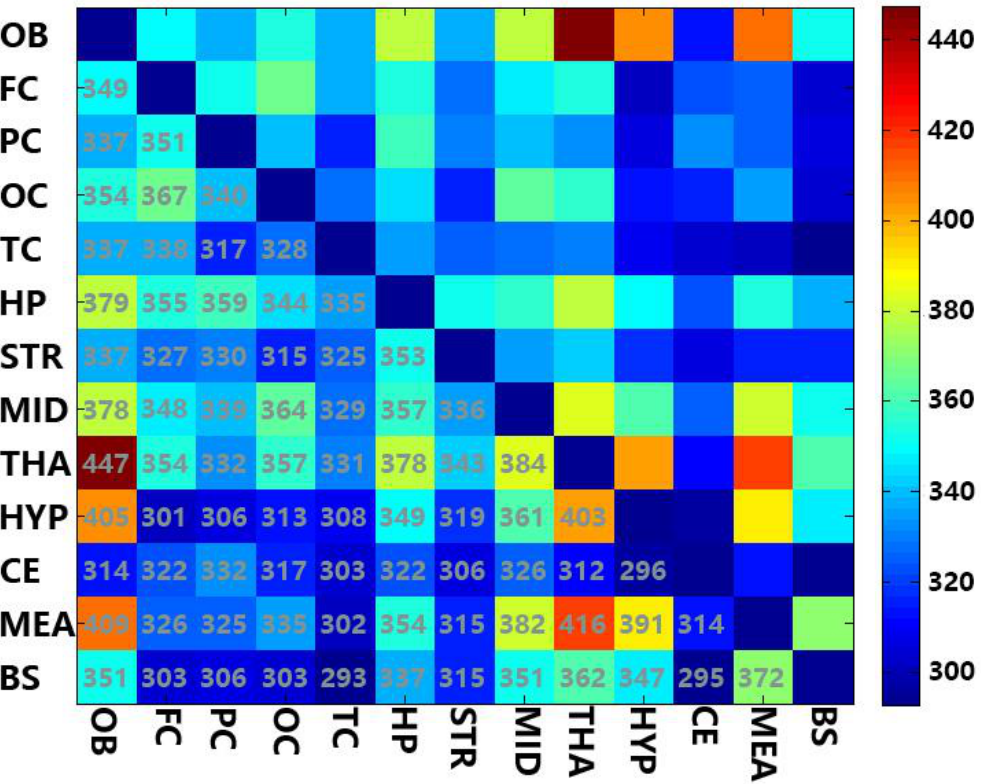
Figure 3. A heat map of common fatty acid species between two different brain regions.